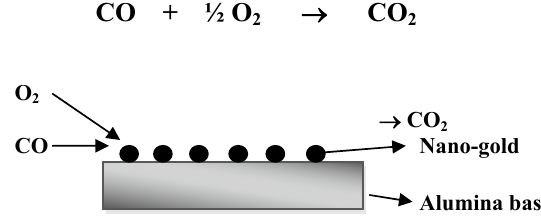
Pictorial presentation of carbon monoxide reacting with oxygen Fig. 4 with the help of gold nano-particles on alumina substrate.